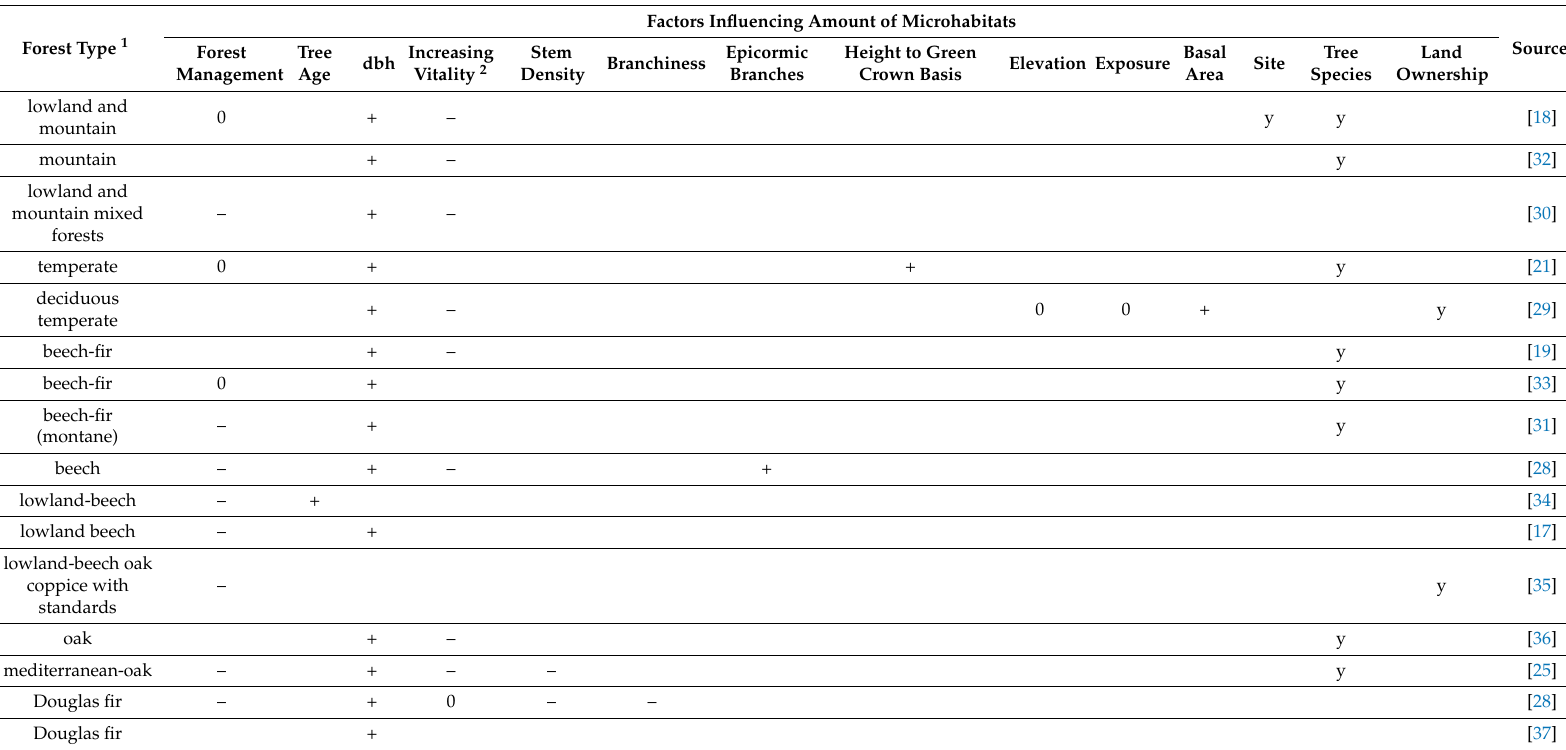
Table 1. Researched factors affecting the occurrence of microhabitats. For continuous variables: + = positive impact, 0 = no impact, – = negative impact. For categorical variables: y = significant differences between